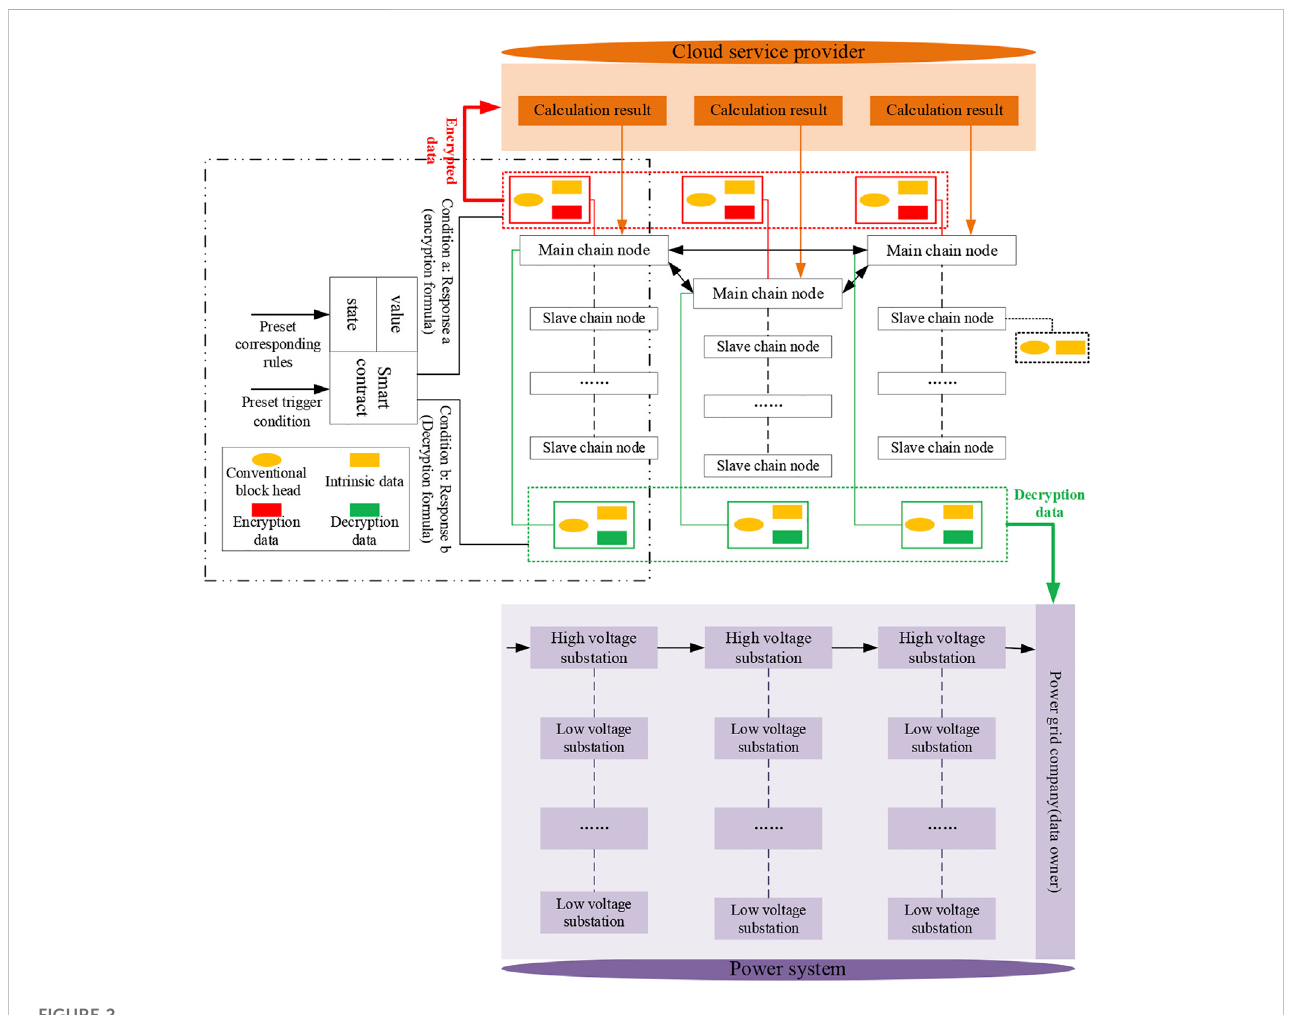
FIGURE 2 Smart contract and block